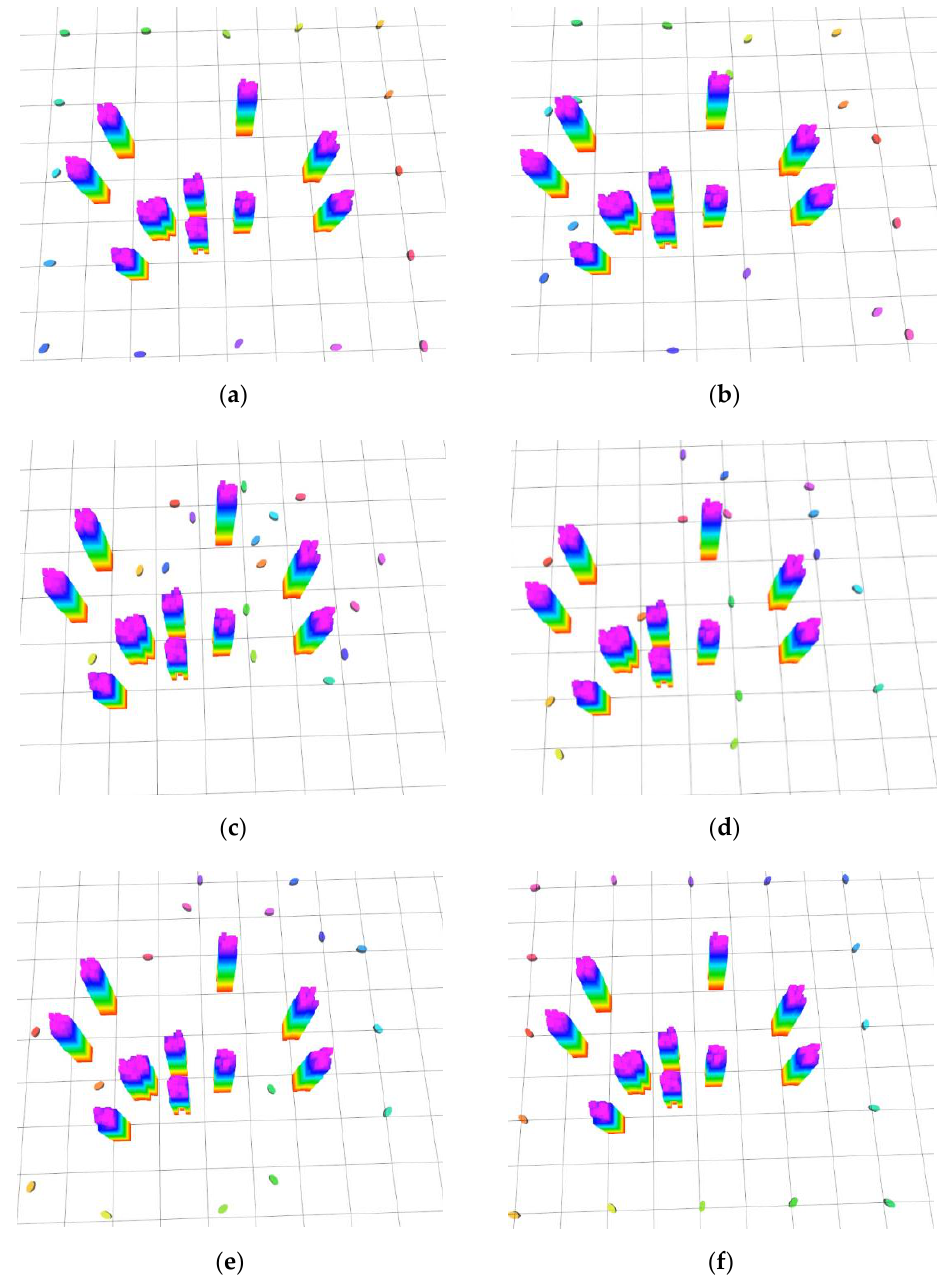
Figure 8. Simulation of multi-robot motion planning, ( a ) T = 0, ( b ) T = 4s, ( c ) T = 8s, ( d ) T = 12s, ( e )